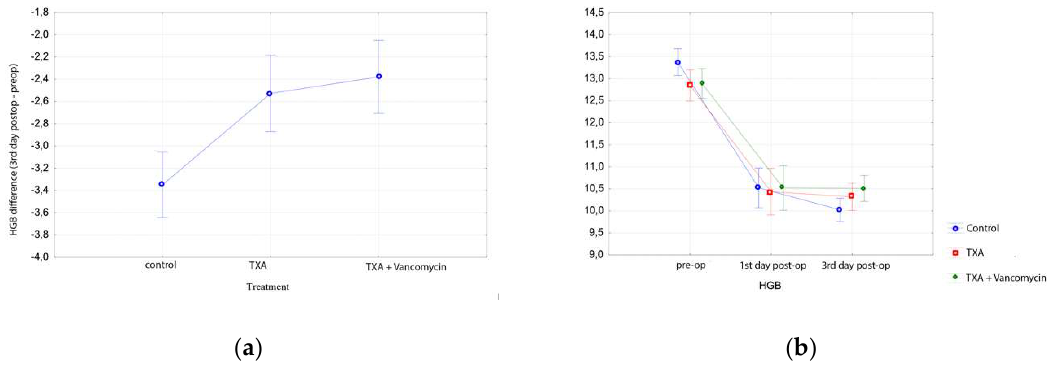
Figure 2. Results in total knee arthroplasty patients: ( a ) Hemoglobin di ff erence between preoperative and 3rd day postoperative value in the control and treatment groups of total knee arthroplasty; ( b ) hemoglobin levels before total knee arthroplasty, at first and third postoperative days in the control and treatment groups.